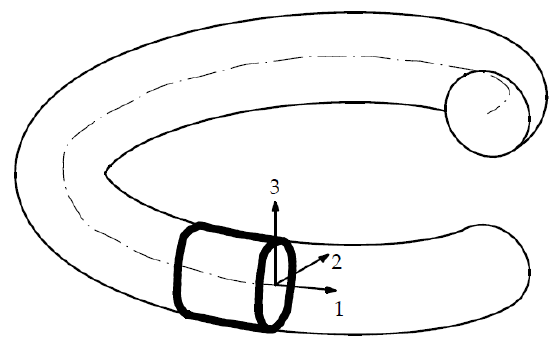
Figure 6. Spring Oscillation Modes.